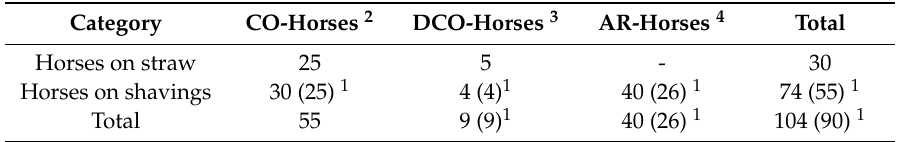
Table 1. Classification of horses per bedding type and observation